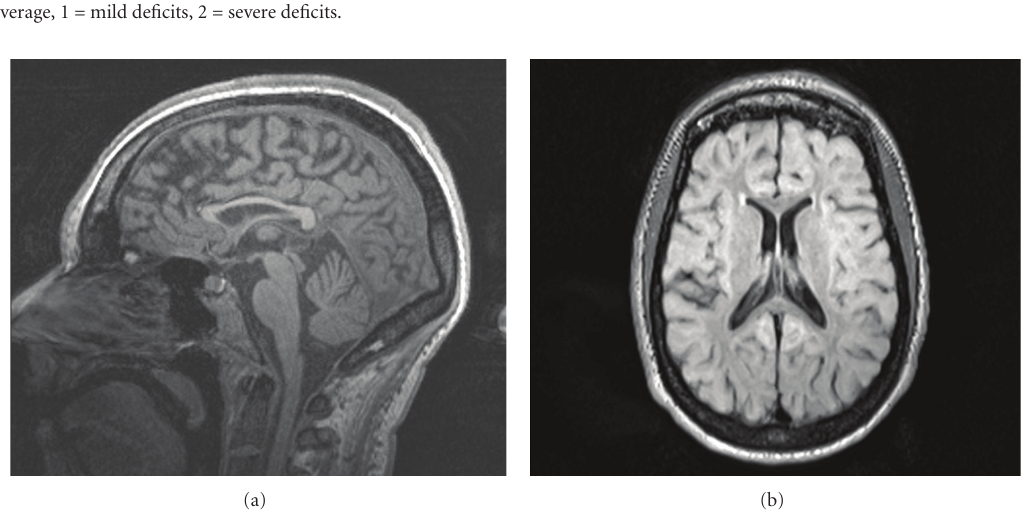
Figure 1: Hypoplastic corpus callosum in magnetic resonance imaging of the patient. (a) sagittal plane; (b) axial plane.